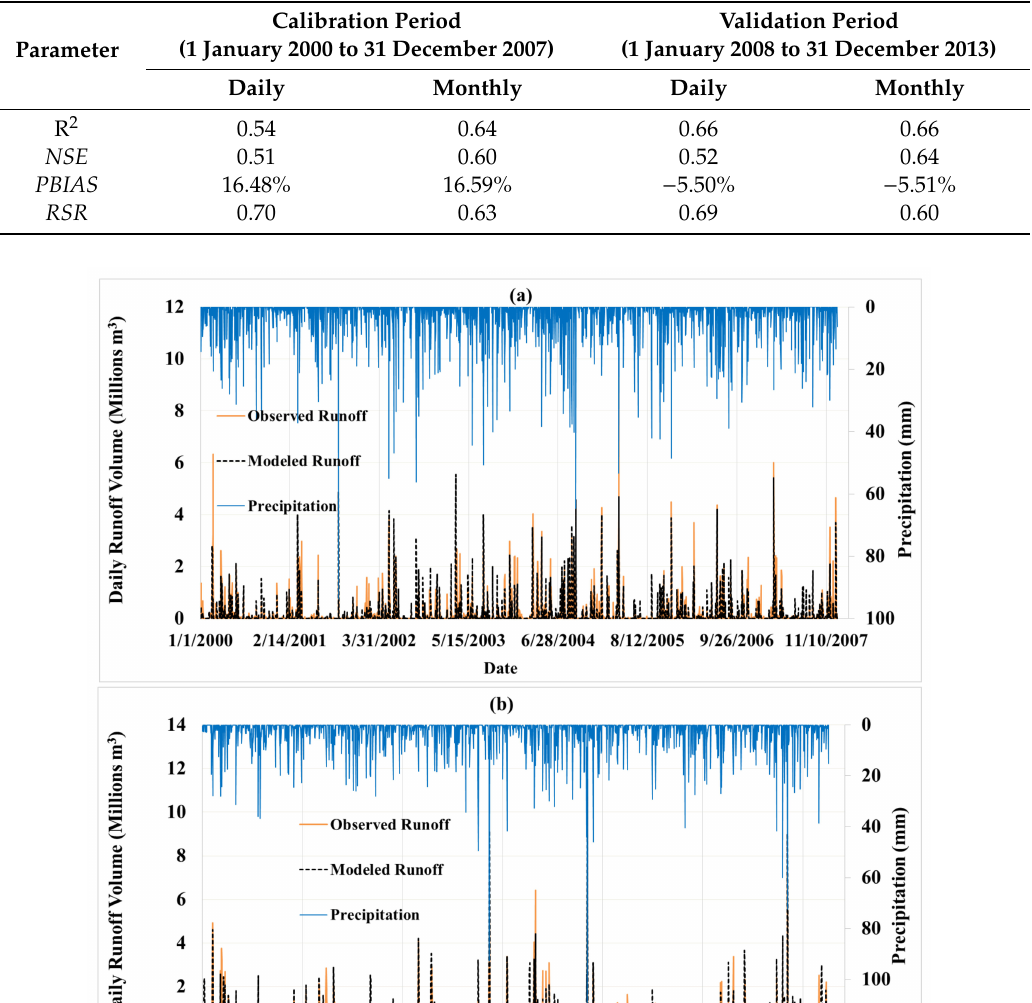
Table 5. Runo ff calibration and validation results for Fall Creek watershed.